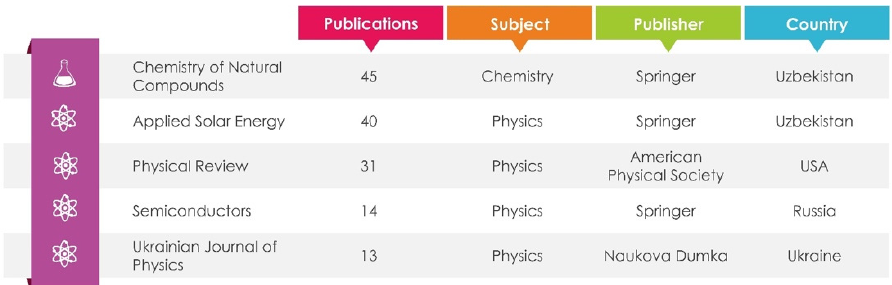
Figure 7. Top-five scholarly journals based on the number of articles.